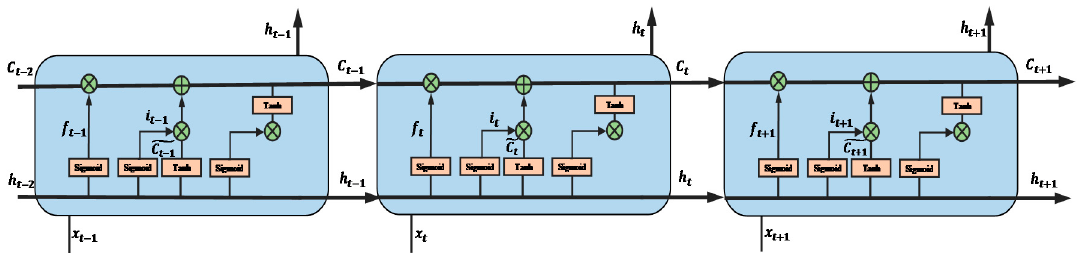
Figure 7. The structure of the long short-term memory (LSTM).